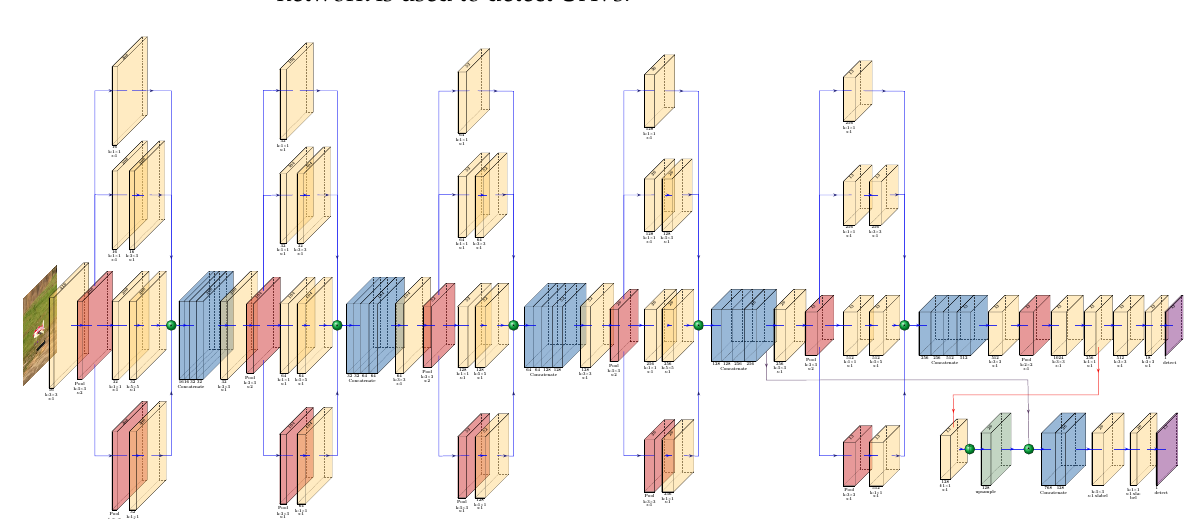
Figure 2. Proposed FastUAV-NET detection architecture. In layers, f and s denote filter size and stride, respectively.